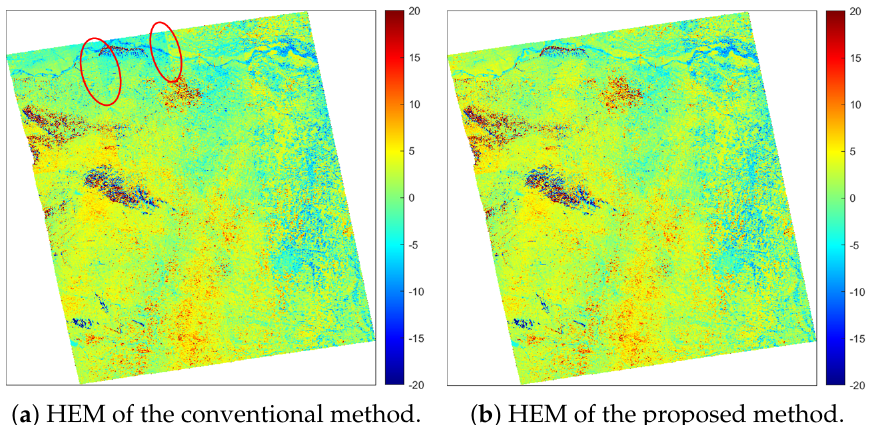
Figure 14. Height error maps of the DEMs adjusted by ( a ) the conventional method and ( b ) the proposed method. The red circles show that the DEMs adjusted by the traditional method have obvious elevation differences in the overlapping